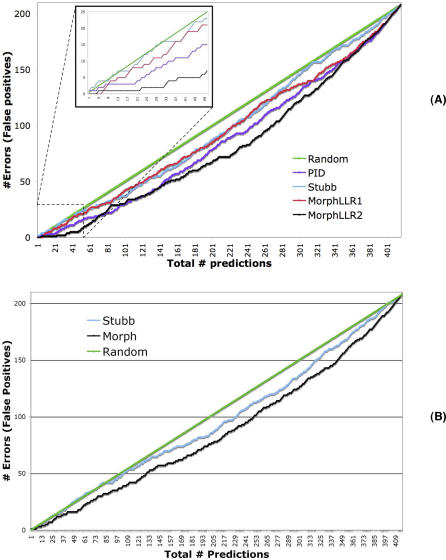
CRM Prediction Accuracy on a Dataset with 208 “Positive” Sequences (CRMs) and 208 “Negative” Sequences (Random Noncoding Genomic Fragments)The y-axis shows the number of negatives included in a given number (x-axis) of top scoring sequences. Green line (diagonal) represents error rate expected by chance.(A) Predictions were made based on percentage identity (PID, purple line), Stubb score (blue), Morph LLR1 score (red), and Morph LLR2 score (black).(B) Predictions were based on the total number of binding sites predicted by Stubb (blue) and Morph (black).